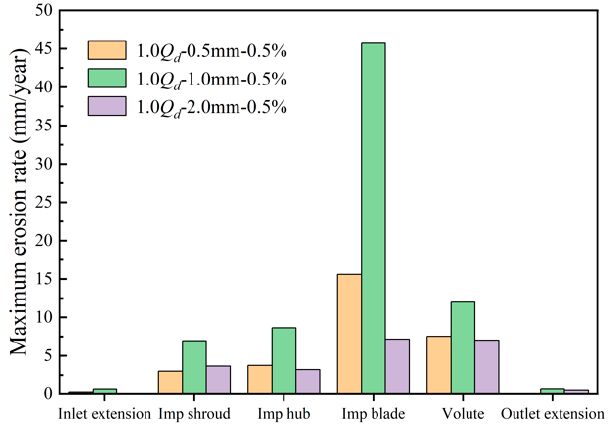
19 of 24 Figure 13. Distributions of particles of different sizes in one flow passage of the pump impeller. The contours of erosion on different components of the pump are figured, and the features on the erosion pattern are very similar to those analyzed in the above section. The severe erosions on the shroud and hub of the impeller occur in the jointed regions with the pressure side of the blade. The severe erosion on the blade occurs in the regions next to the inlet and outlet of the blade. If the particle size is small and more particles are pre- sented, the erosive area is extended toward the middle of the blade. The severe erosion on the volute, as observed in Figure 10, occurs near the pump tongue. Figure 14 shows the maximum annual erosion rates on different components of the pump for different particle sizes. It is seen that the erosions on the shroud and hub of the impeller, the volute, and the extensions of the inlet and outlet are not very sensitive to the particle size, while the erosion on the pressure side of the blade is strongly affected by the particle size. Figure 15 shows the relationships between the maximum annual erosion rate and the particle diameter. On both the blade and volute, the erosion rate is a nonlinear relationship with particle size, and the maximum erosion occurs in the case of the 1 mm particle. For the 2 mm particles, each particle has a larger mass and kinetic energy. How- ever, the presented particles are significantly fewer at the fixed volume fraction, and the collisions with the pump surfaces are scarce, causing the lowest annual erosion rate. For the 1mm particles, although the particle mass and kinetic energy are reduced, the number of particles is significantly increased, as well as the collision frequency with the pump surface. The overall effect is to cause the largest erosion rate. For the 0.5 mm particles, the particle mass and kinetic energy are further reduced while the number of particles is greatest. However, it is found that a buffering layer is formed on the surface when the presented particles are intensively accumulated in the vicinity of the surface. The inner